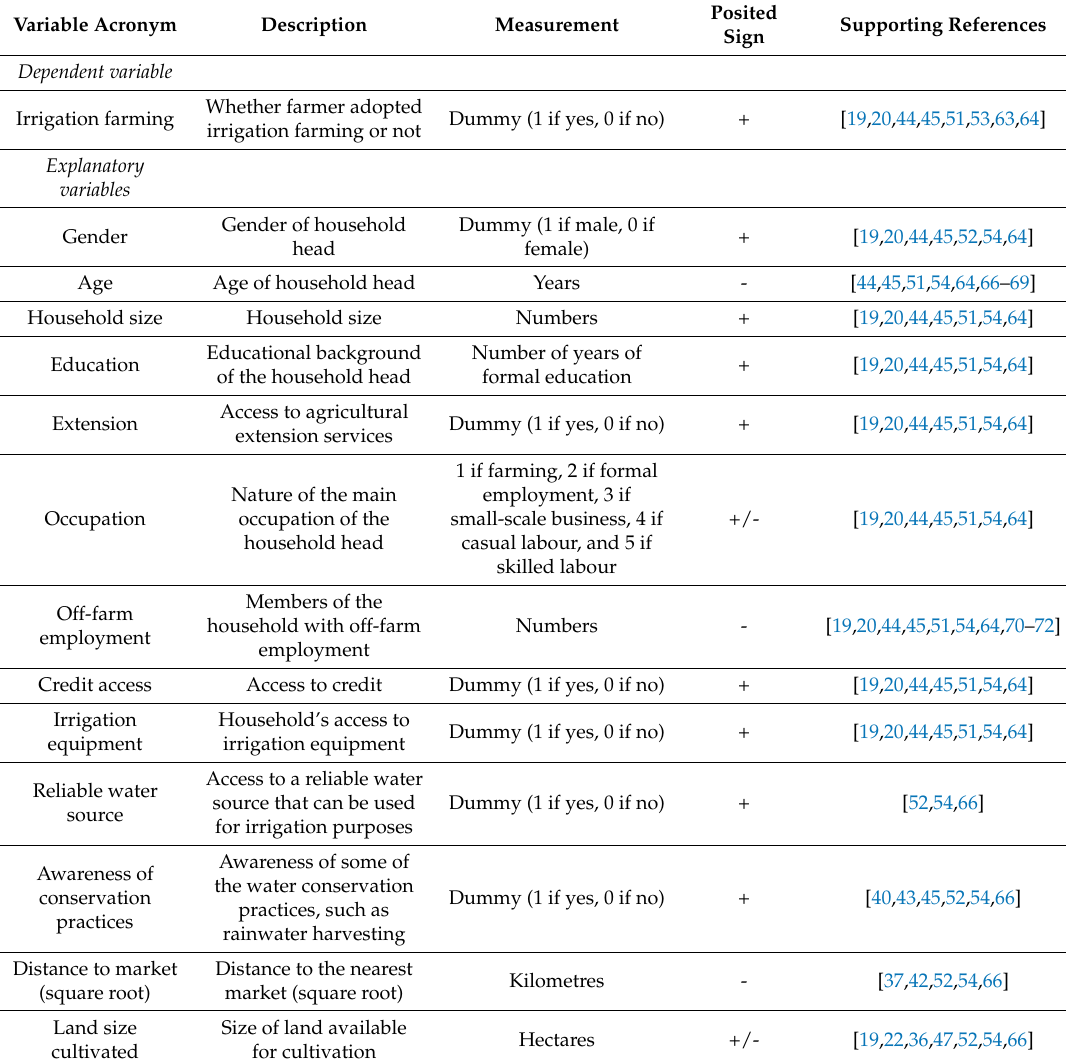
Table 2. Description of the variables specified in the binary logistic model of